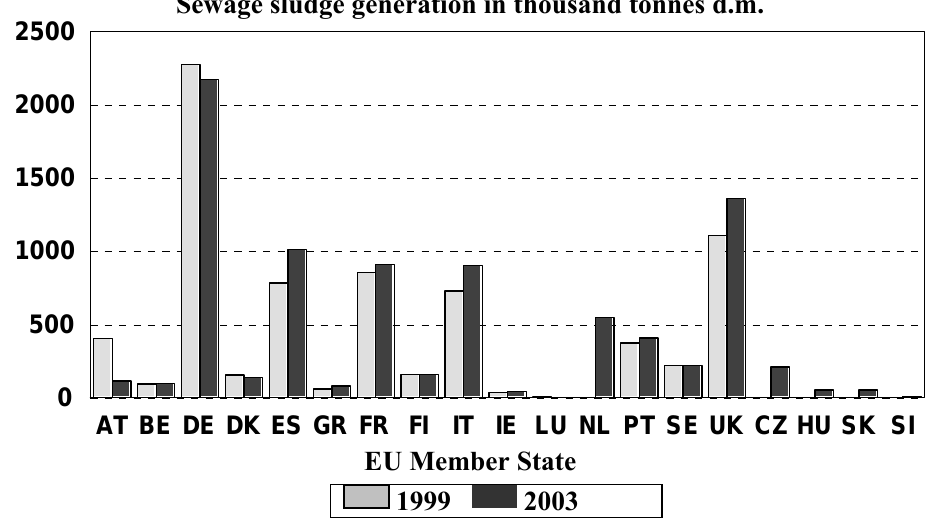
Figure 25: Potential sewage sludge in the EU in the years 1999 and 2003 Figure 26 resulted from the assessment of sewage sludge disposal in the individual member states of the EU from different sources [Schmelz, 2007; Wieland, 2003 [jb21] ]. The portions of the individual disposal ways from earlier (e.g. from the year 2000) or also later years (e.g. from the year 2005) had to be transferred on the sewage sludge amount of the baseline year 2003.